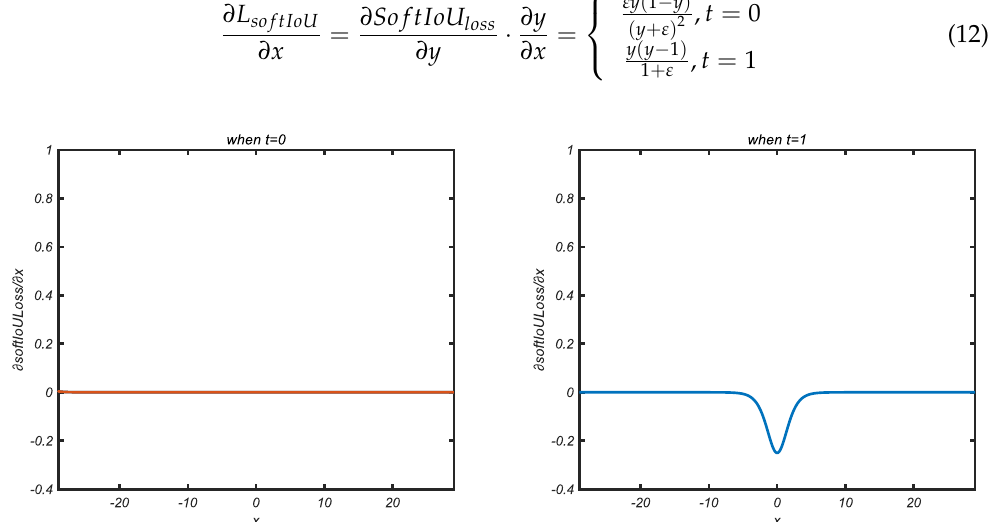
Figure 5. The gradient of the softIoU loss for negative background samples ( t = 0) and positive target samples ( t =